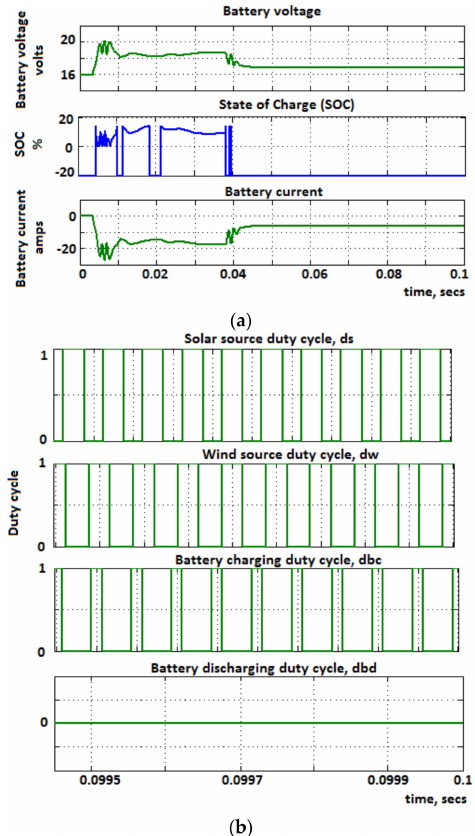
Figure 11. ( a ) Battery voltage, final SOC and battery current; ( b ) final duty